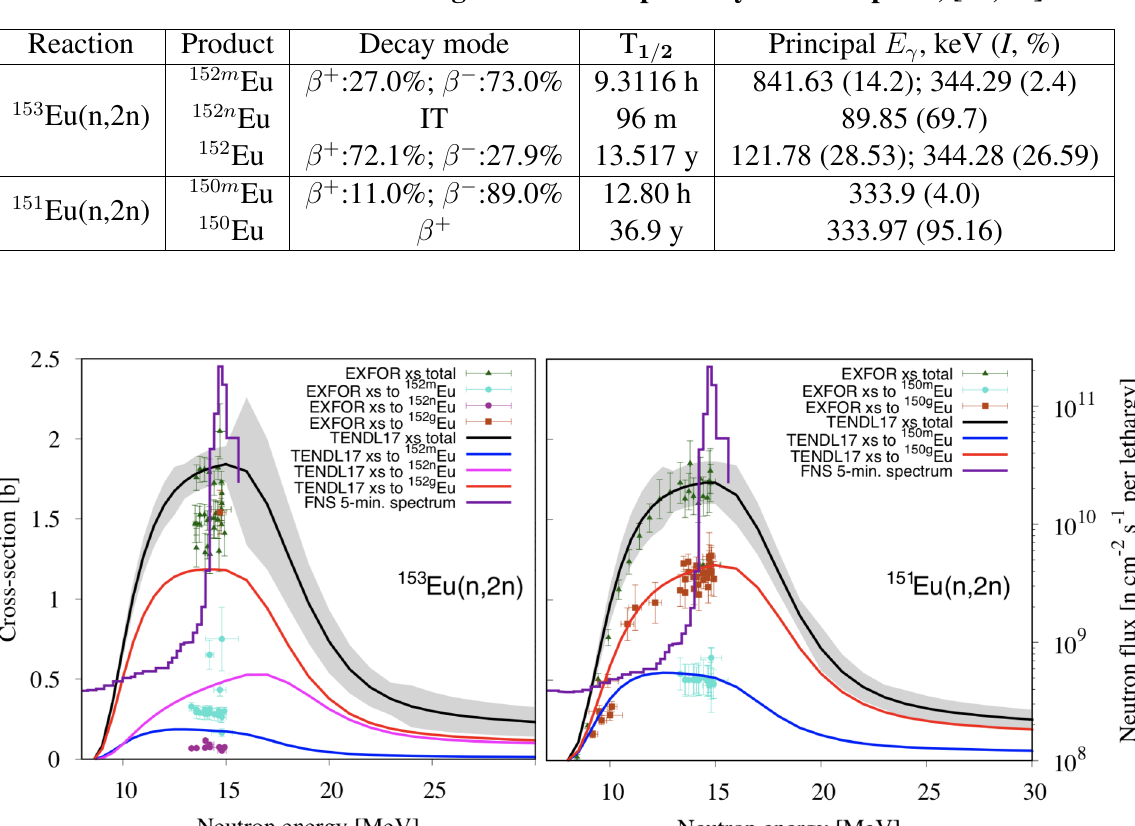
Table 2: Details of the investigated reaction pathways for europium, [17, 18]